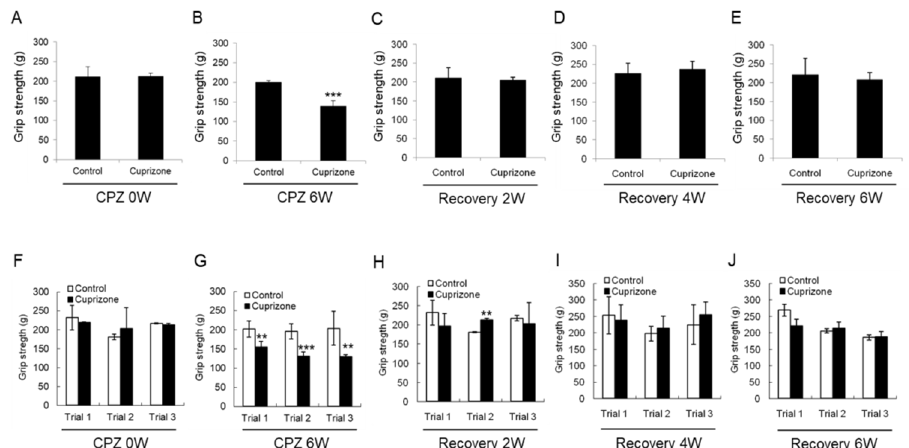
Figure 3. Results of the grip strength test. ( A – E ) The graphs show the average grip strength of three different trials in the control or cuprizone group. Data are expressed as mean ± standard error of the mean (SEM). ( F – J ) The graphs show the grip strength in three different trials. Data are expressed as mean ± standard deviation (SD). The final data was made with the results of the total individuals minus the number of sacrificed mice. N = 7 for each group, and differences between groups are expressed as ** p < 0.01, *** p < 0.001.